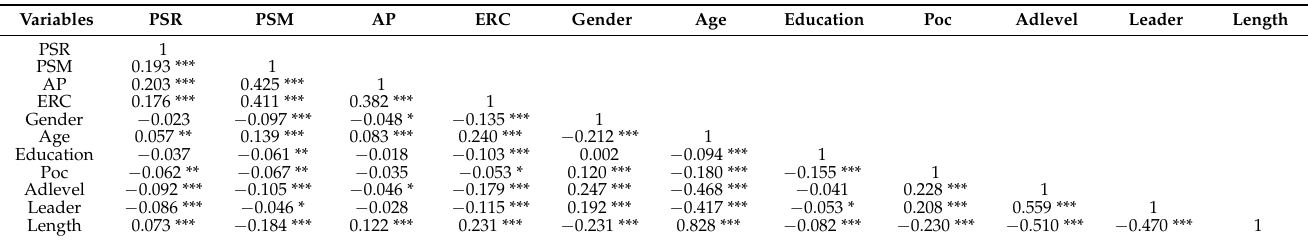
Table 3. Correlation matrix of the studied